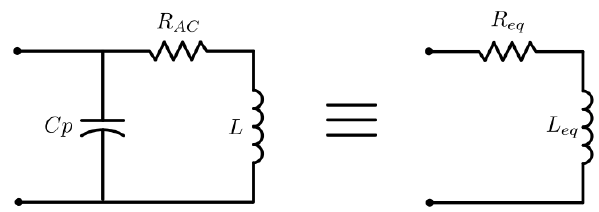
Figure 3. Coil equivalent circuit.